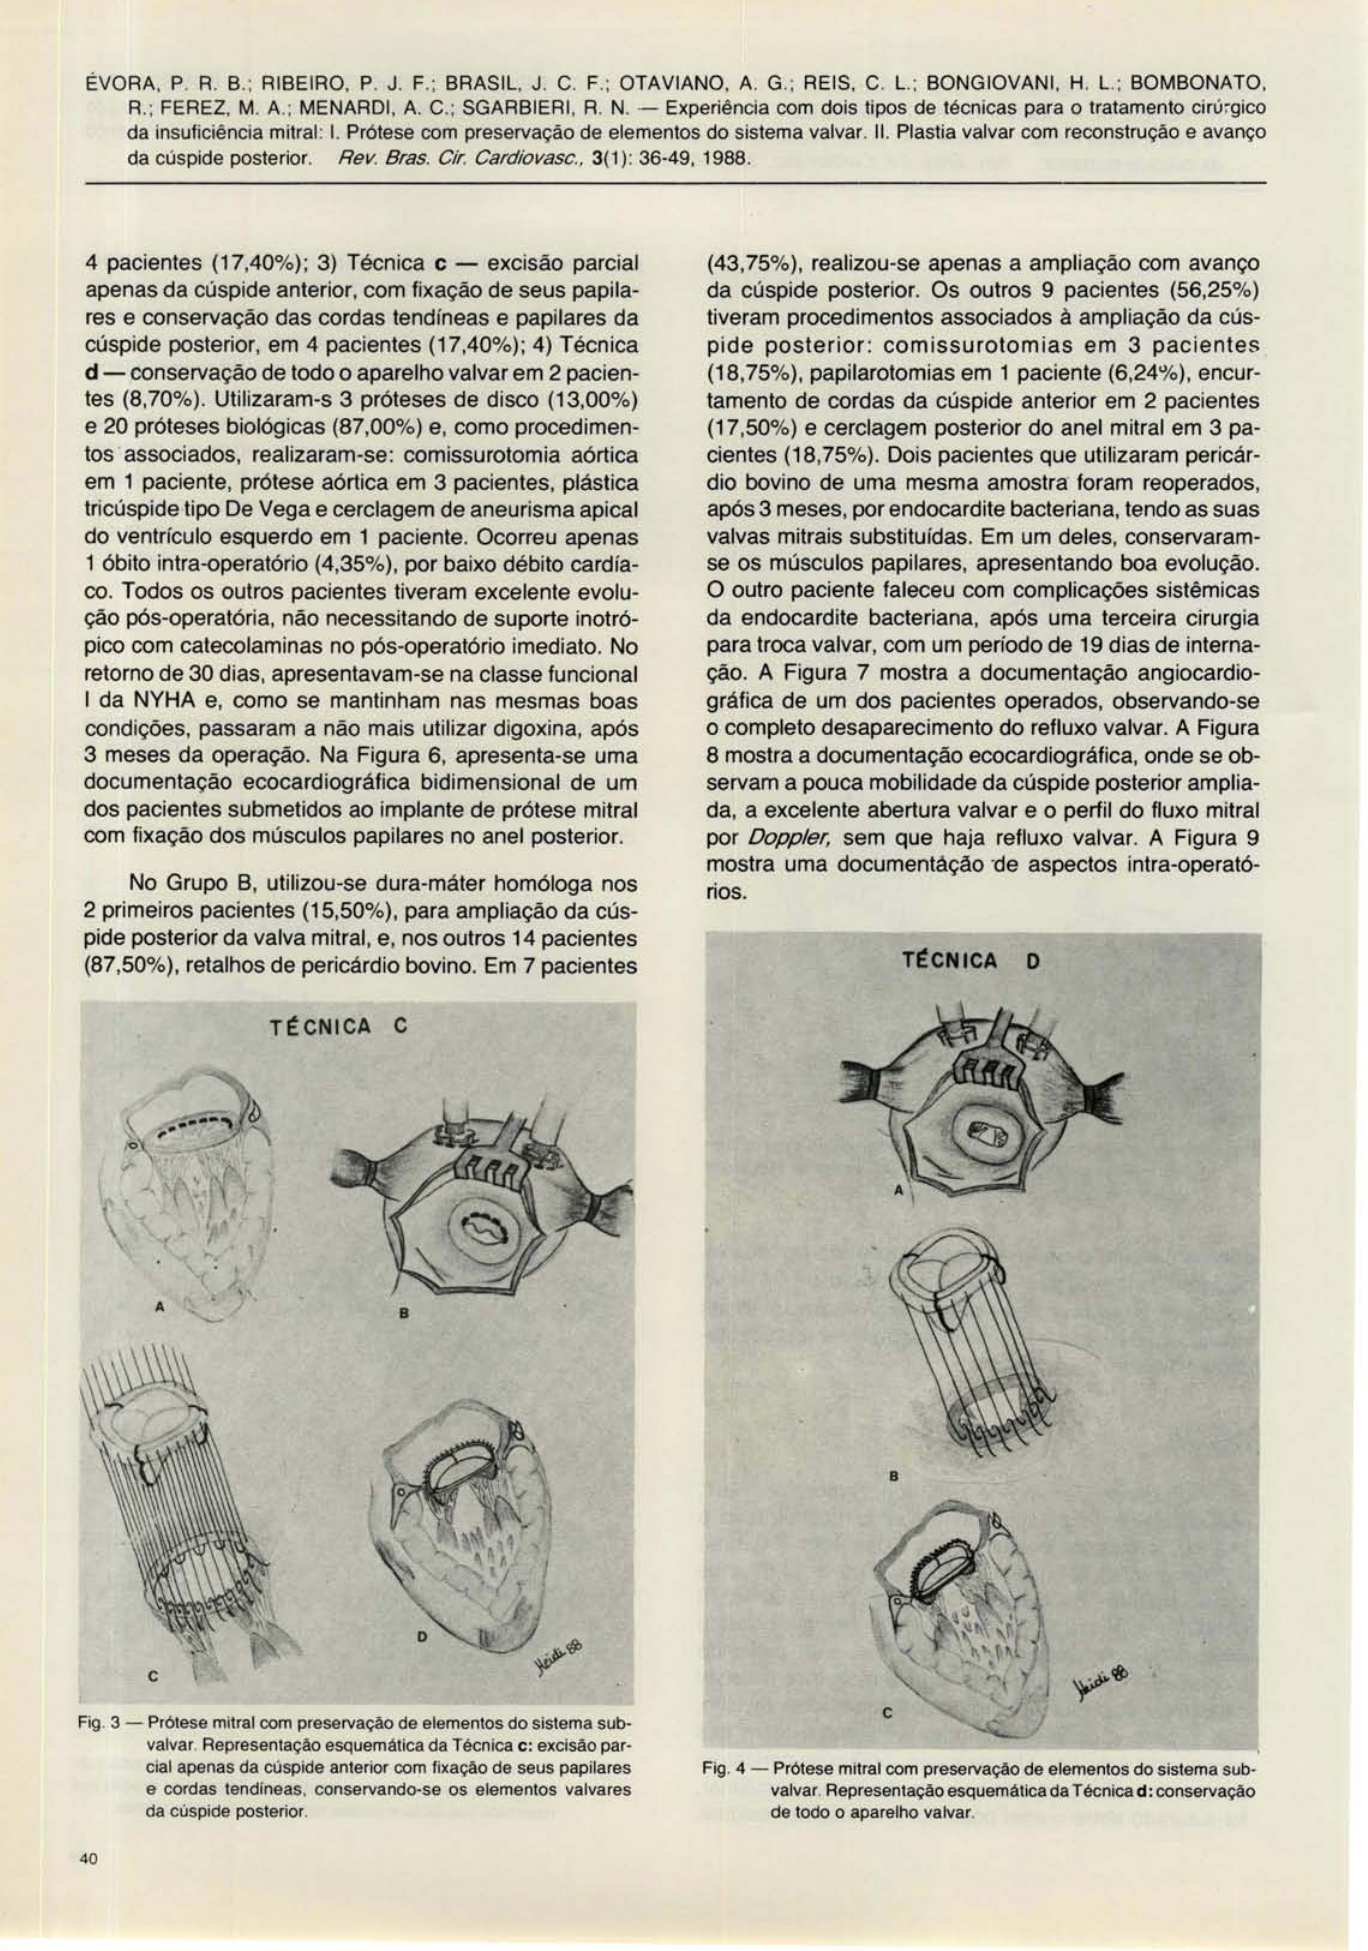
Fig. 4 - Prótese mitral com preservação de elementos do sistema sub valvar. Representação esquemática da Técnica d: conservação de todo o aparelho